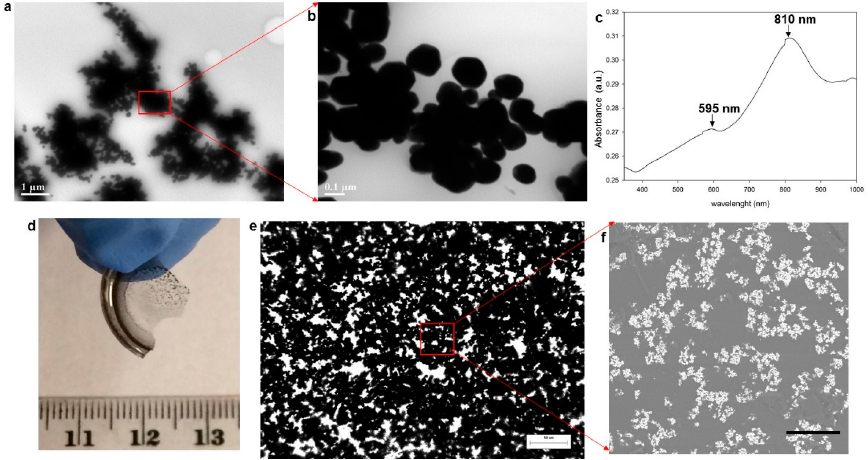
Figure 3. ( a ) Transmission electron micrograph; ( b ) corresponding magnified view; ( c ) UV–Vis–NIR